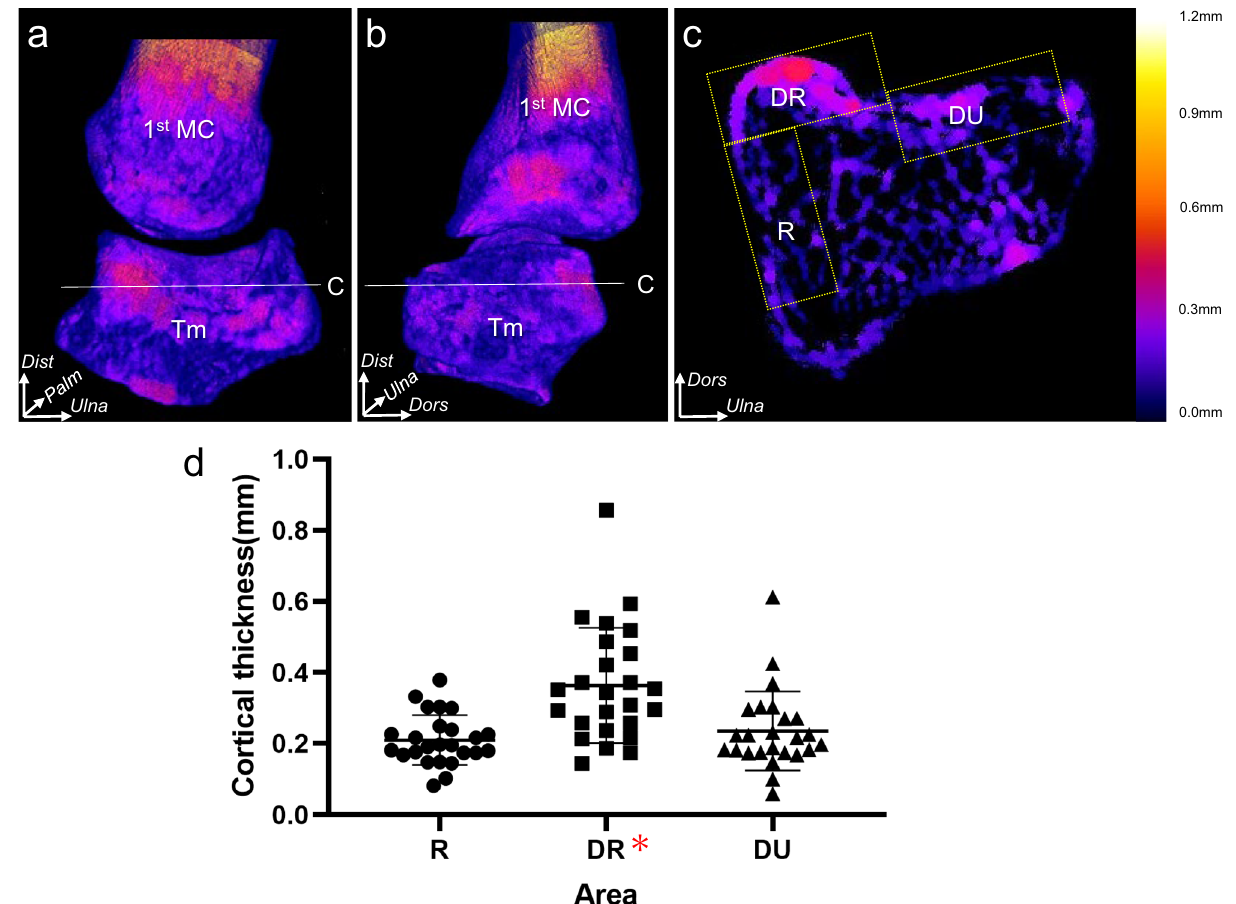
Figure 2. Evaluation of cortical bone thickening in the trapezium and the proximal part of the metacarpal bone. Mapping of the cortical thickening in the right trapeziometacarpal joint was performed after image processing. The thicker the cortical bone of the point, the brighter is the color of the point. ( a , b ) dorsal and radial aspects of three-dimensional cortical bone thickness images. ( c ) axial section at the level of the white line in ( a ) and ( b ). The cortical bone is divided into the radial side of the dorsal aspect (DR), ulnar side of the dorsal aspect (DU), and radial aspect (R) using equivalent rectangles, which are indicated by yellow dotted areas. The color bars (from black to navy blue, violet, red, orange, yellow, and white) indicate the cortical bone thickness distribution (mm). ( d ) scatterplot showing cortical bone thickness of the rectangles. Cortical bone thicknesses are presented as means and standard deviations. The mean cortical thickness of the DR (red asterisk) was significantly greater than the corresponding thicknesses of the DU and R (repeated-measures analysis of variance and Bonferroni post-hoc test, both P < 0.001). Dist , distal; Ulna , ulnar; Dors , dorsal; Palm , and ≥ 85 years) and sex-based. The intergroup differences were significant for all parameters, except for those in the male group (Supplementary Table S1). Macroscopic analysis of the dorsal and radial aspects of the TMC joint. On the dorsal aspect, the FDI originated from the proximal part of the 1st MC via a tendinous structure (Fig. 3a,b). After removal of the muscular parts of the FDI, the origin of the FDI aponeurosis was observed to extend proximally and intermin- gle with the dorsal TMC joint capsule to form the capsuloaponeurotic complex (Fig. 3c). These findings were observed in all specimens. On the radial aspect, the abductor pollicis brevis (APB) originated from the flexor retinaculum, scaphoid, and trapezium and was inserted into the radial side of the proximal phalanx of the thumb (1st PP; Fig. 4a). The OPP and superficial flexor pollicis brevis (FPB) originated from the flexor retinaculum and the TMC joint capsule via muscular parts and were inserted into the 1st MC and 1st PP, respectively (Fig. 4b). The muscular border between the OPP and the superficial FPB could not be identified clearly. The abductor pollicis longus (APL) main tendon was attached to the radial base of the 1st MC, which corresponded to the brightly colored area in Fig. 2b, distal to the joint capsule attachment (Fig. 4b). After the removal of the muscular parts of the FPB and OPP, the radial joint capsule was observed to be thin (Fig. 4c). The APL supernumerary tendon was inserted into the TMC joint capsule in 16 out of 18 thumbs. The remaining two thumbs were from different cadavers.